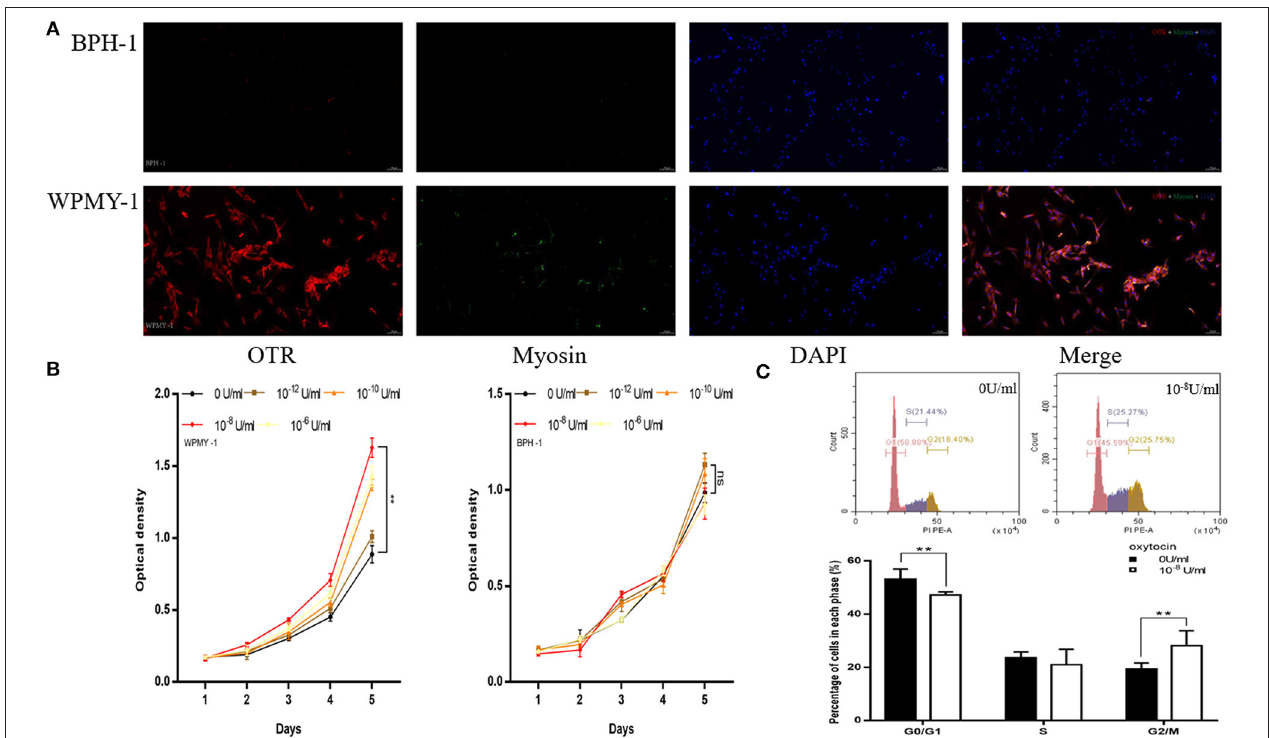
FIGURE 5 | Immunofluorescence, cell proliferation and Flow Cytometry of human prostate cell lines. (A) Immunofluorescence of human prostate cell line. Cy3-immunofluorescence (red) indicates OTR expression. FITC-immunofluorescence (green) indicates MHC expression. DAPI (blue) indicates cell nuclear staining. Merged image indicates OTR, MHC and DAPI. (B) Cell proliferation of prostate cell treated with OT. X-axis is culture time and Y-axis is OD. (C) Flow Cytometry to analyze for cell cycle of WPMY-1 cells treated with OT. Upper: Flow Cytometry analyses for cell cycle in WPMY-1 cell treated with selected concentration of OT at 0 and 10 − 8 U/ml. Lower: Bar graph for the percentage of WPMY-1 cells in each cell phase. Cells cultured with 0 U/ml of OT are used as controls whereas cells cultured with other dosages of OT are the treatment groups. ** P < 0.01 vs.